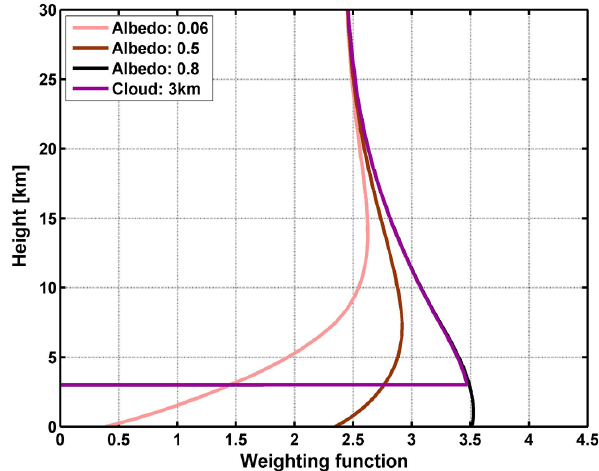
Fig. 4. Satellite weighting functions at 345.5nm as function of surface albedo (0.06, 0.5 and 0.8 for a surface at sea level) and for a fully cloudy scene (cloud top height: 3km, cloud albedo: 0.8). Calculations are made for a pure nadir observation geometry (line- of-sight angle: 0 ◦ ) and a solar zenith angle of 45 ◦